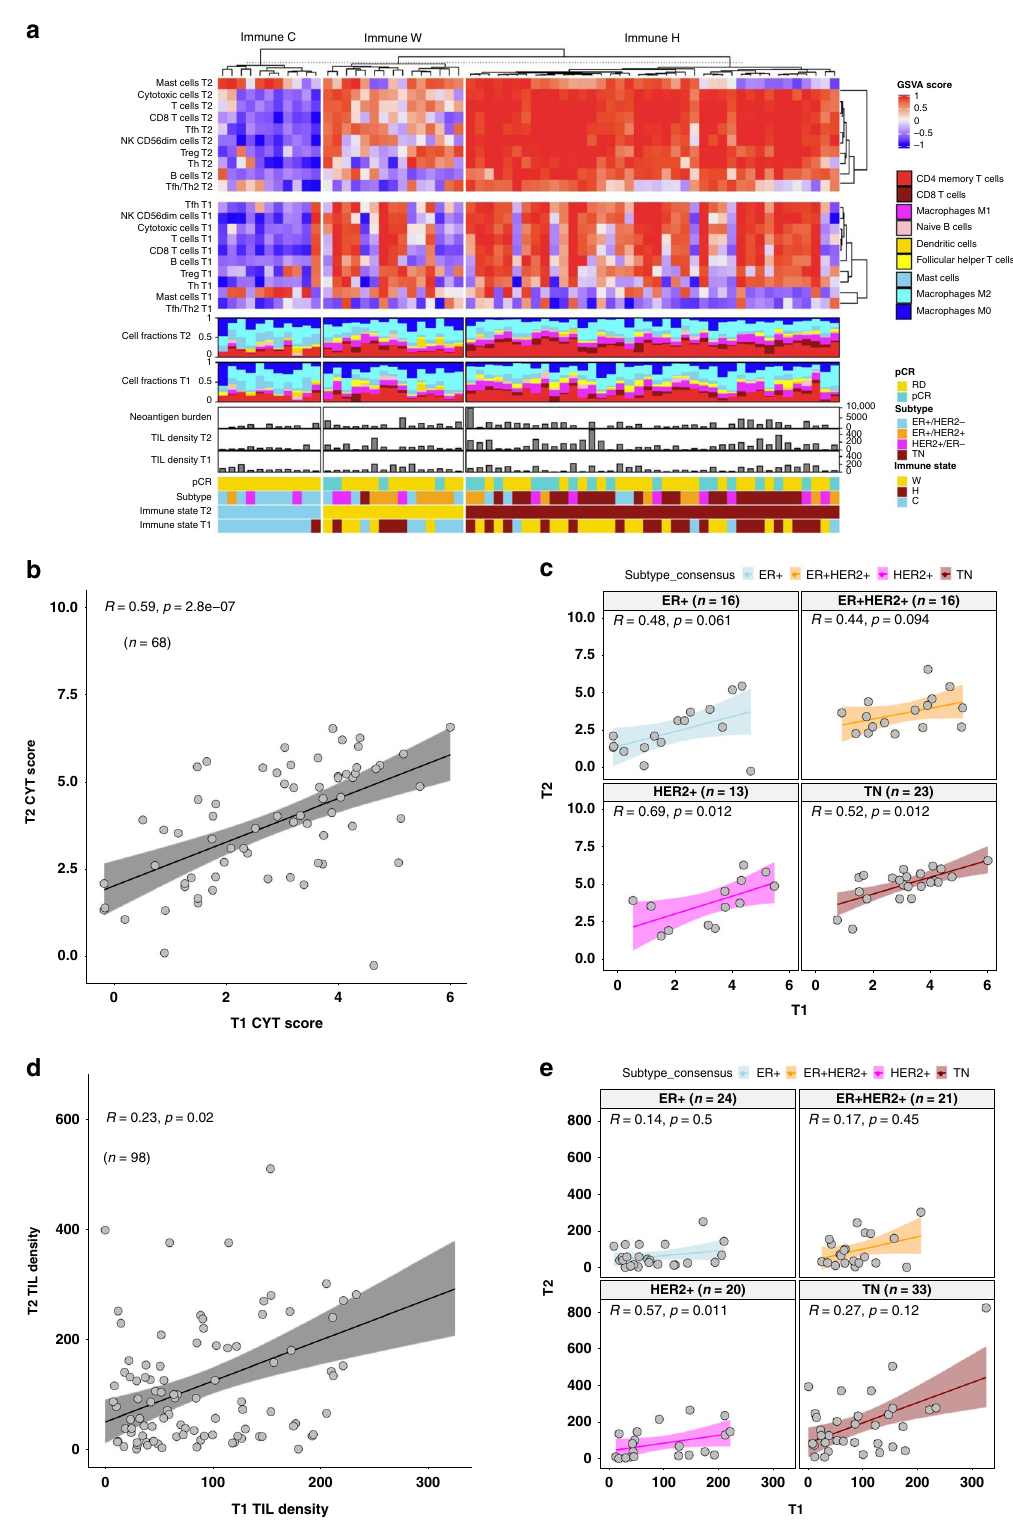
Fig. 6 Comparing immune states at on-treatment vs. baseline. a Integrated map of immune signatures and immune cell fractions for paired T2 and T1 samples. Immune state classi fi cations were based on T2 samples. b , c Scatterplots showing CYT scores in paired T1 vs. T2 samples in the overall cohort ( b ) and different subtypes ( c ). Source data are provided as a Source Data fi le. d , e Scatterplots showing TIL densities in paired T1 vs. T2 samples in the overall cohort ( d ) and different subtypes ( e ). Statistical signi fi cance of correlation was determined using the Spearman method. Shaded error band around the regression line indicates the 95% con fi dence interval. Source data are provided as a Source Data fi